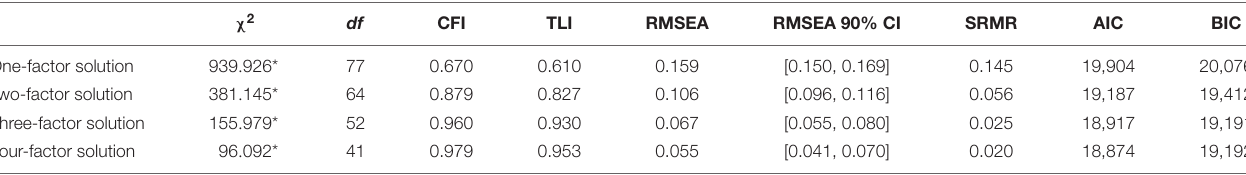
TABLE 3 | Goodness of Fit Statistics and Information Criteria for the EFA on the HCSS (sample 1). χ 2 df CFI TLI RMSEA RMSEA 90% CI